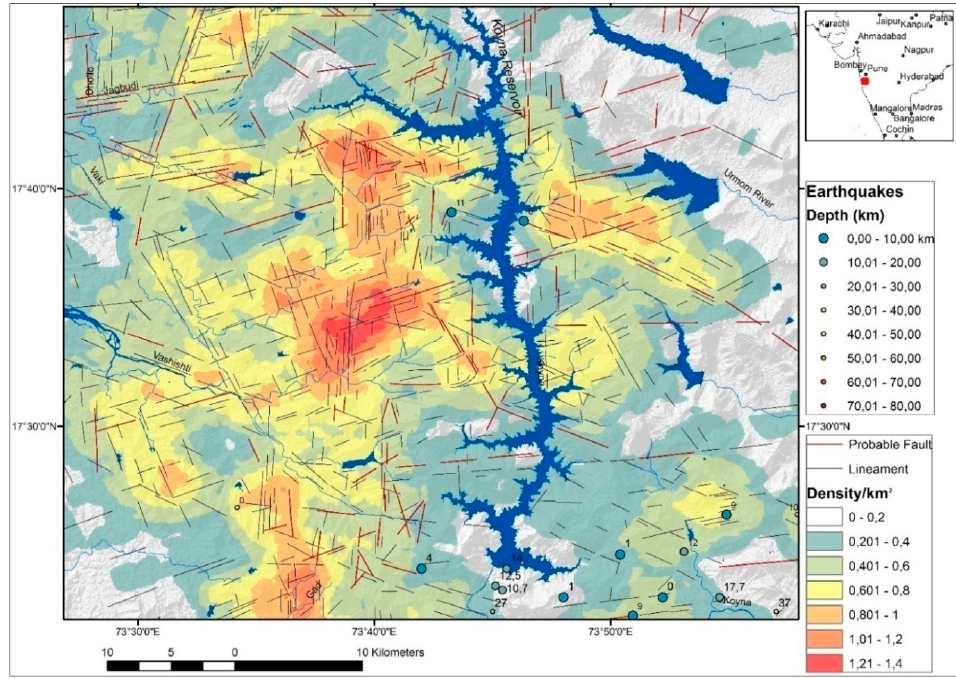
Figure 13. Lineament density and earthquake depth (km).